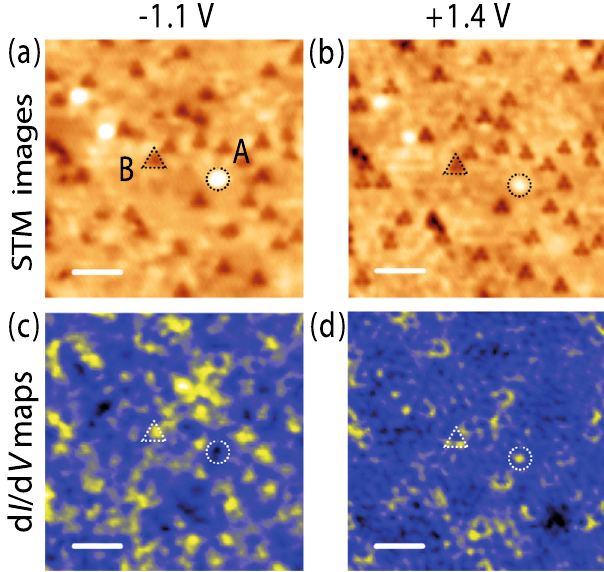
Fig. 3 Atomic resolution STM/S images of native point defects at the MnBi 2 Te 4 surface. Topographic STM images were taken at 1.2 K on the same area showing a the occupied ( − 1.1 V) and b unoccupied (1.4 V) states and their corresponding d I /d V maps ( c ) and ( d ), respectively. We observe two different types of defects located in the surface Te layer (type A) and in the subsurface Bi layer (Type B). The scale bar is 2 nm. For the bias-dependent topographs and d I /d V maps in the [ − 1.5: + 1.5 V] range see Supplementary Fig.